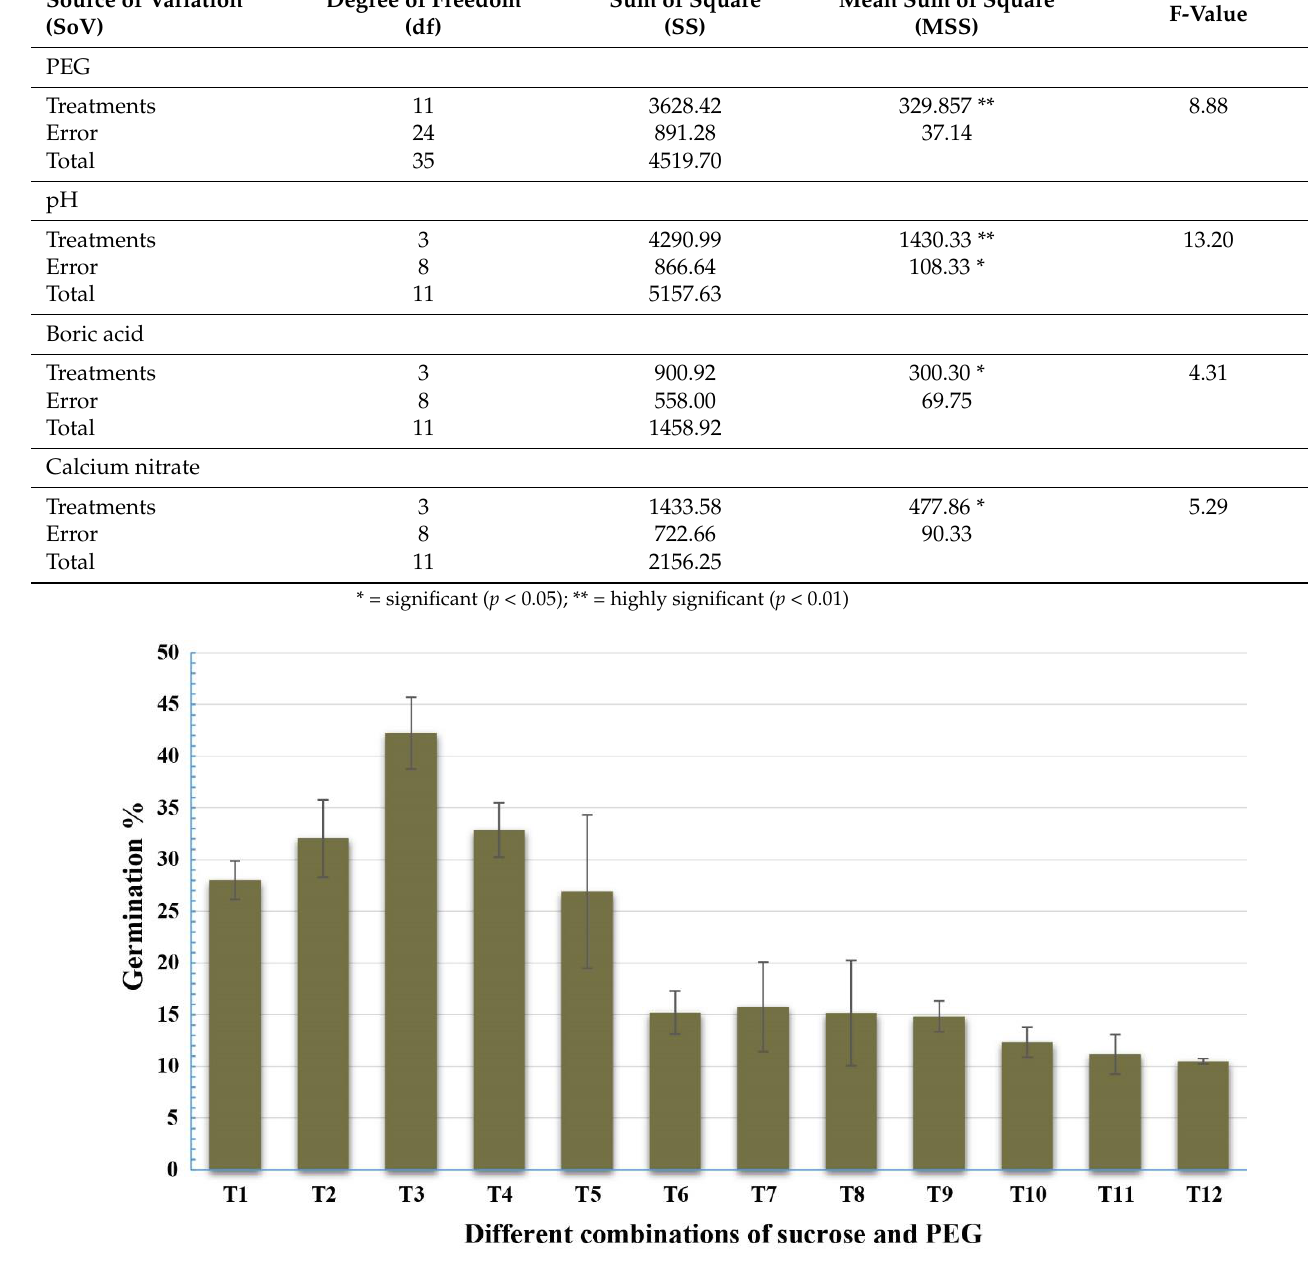
Figure 3. Effect of sucrose and PEG on pollen germination (%) of Gladius+Sr50. The value for each treatment is the mean percentage counts from three microscopic fields of three slides. Least significant difference (LSD; p = 0.05) for treatments was 4.97%. Error bars represent SE of the means.